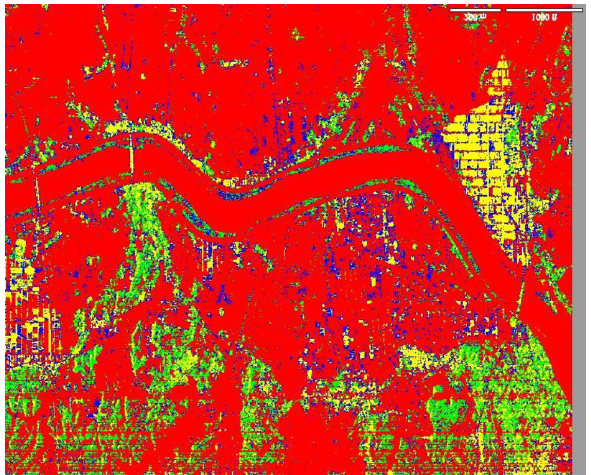
Figure 6. Wishart supervised